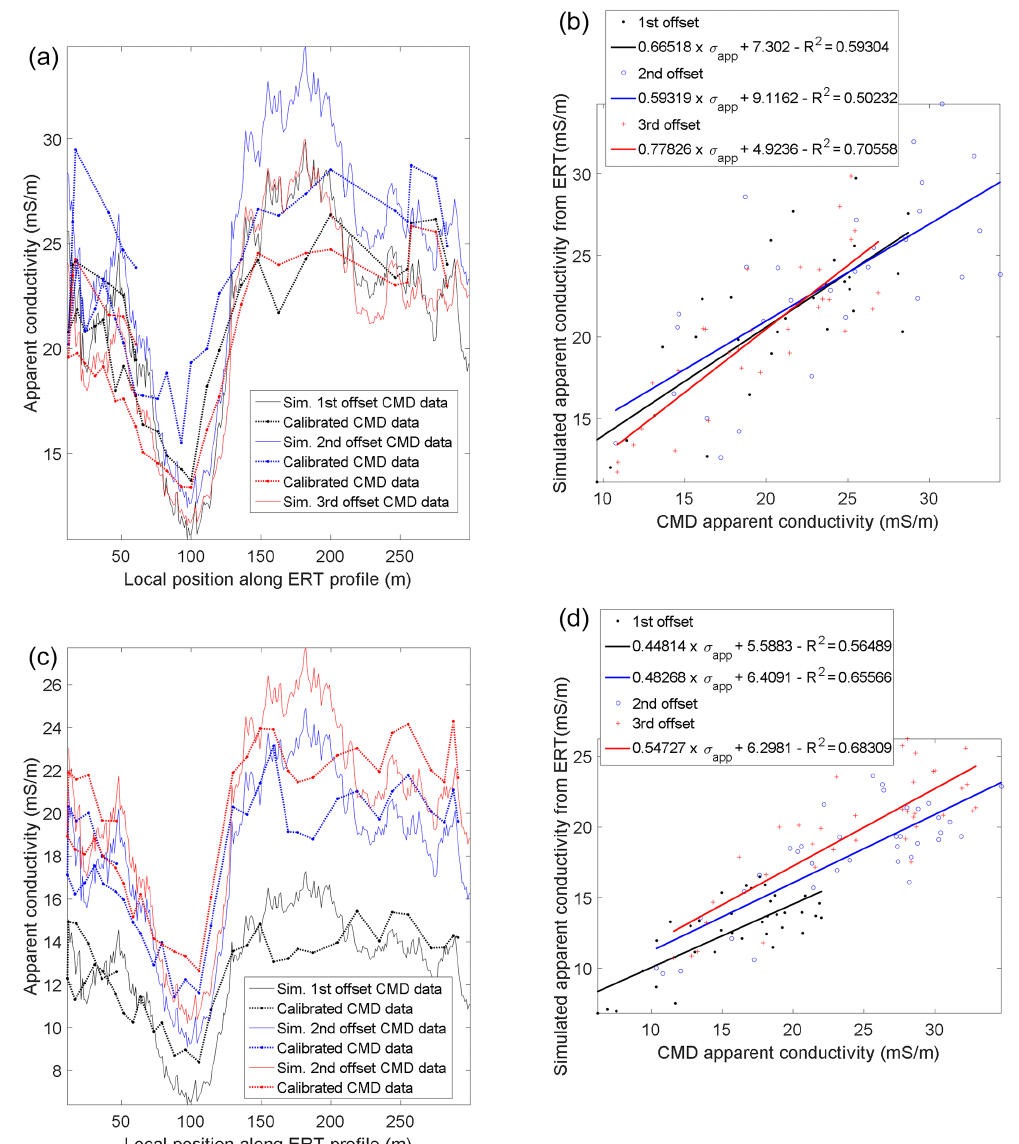
Figure 6. HCP (a) and VCP (c) calibration results obtained along the reference profile: simulated apparent CMD conductivities based on the ERI inversion compared to the calibrated EMI measurements. Scatter plots of the HCP (b) and VCP (d) measured vs. simulated apparent conductivities. The solid lines indicate the corresponding linear